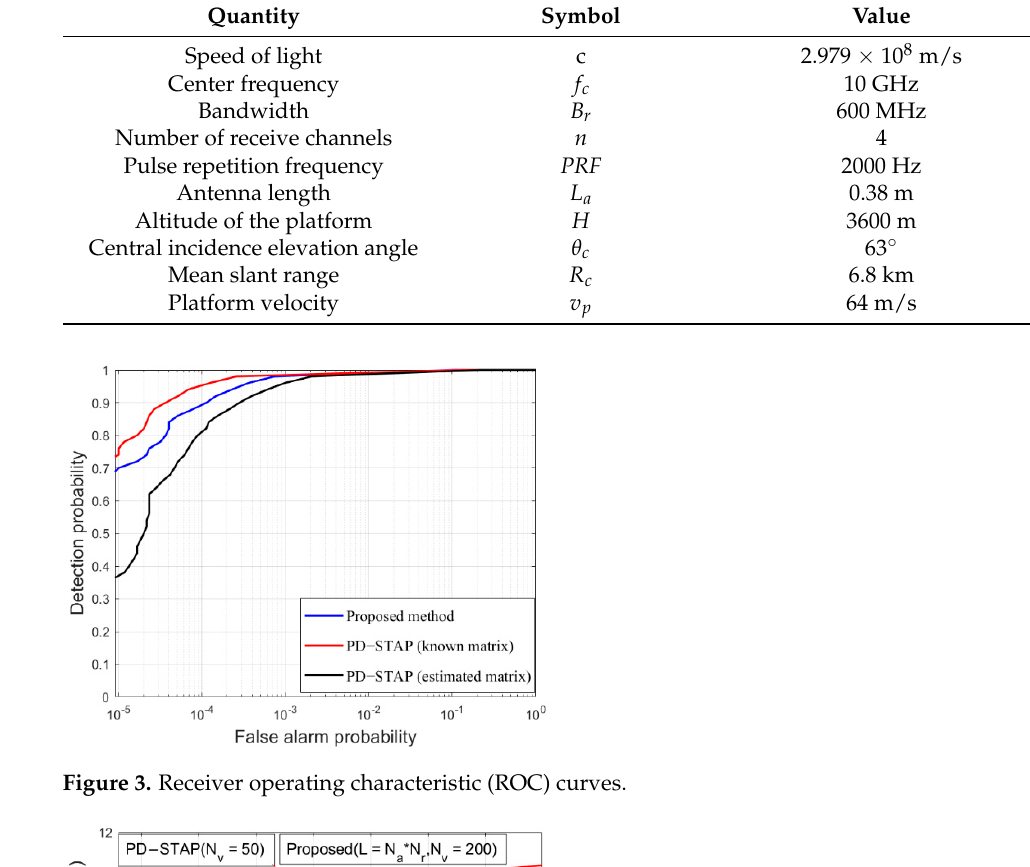
Table 1. System parameters.